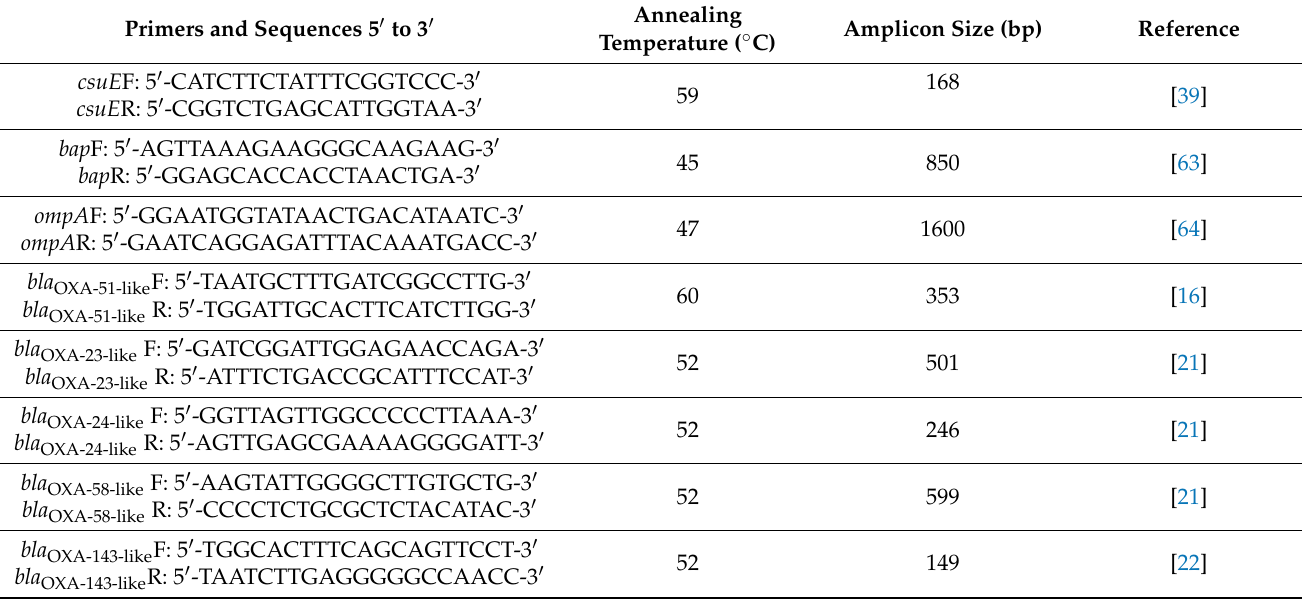
Table A1. PCR primers, amplicon sizes, and references used in this